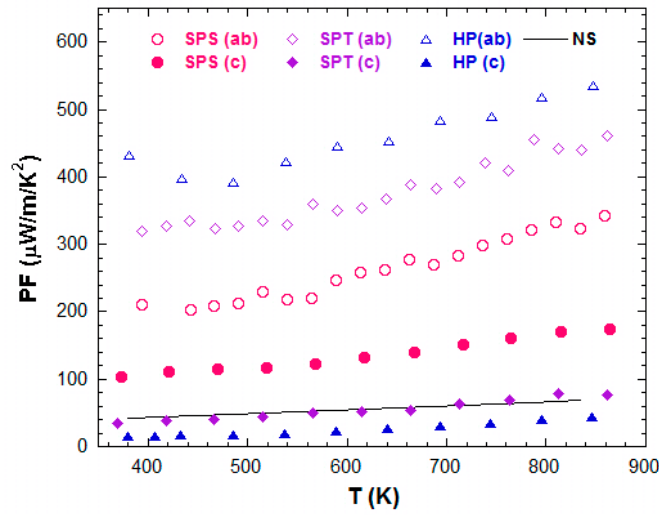
Figure 7. Temperature dependence of the resulting power factor (PF) along both principal directions in the SPS, SPT, and HP stacks. PF NS (T) obtained for the NS sample is also plotted for comparison.